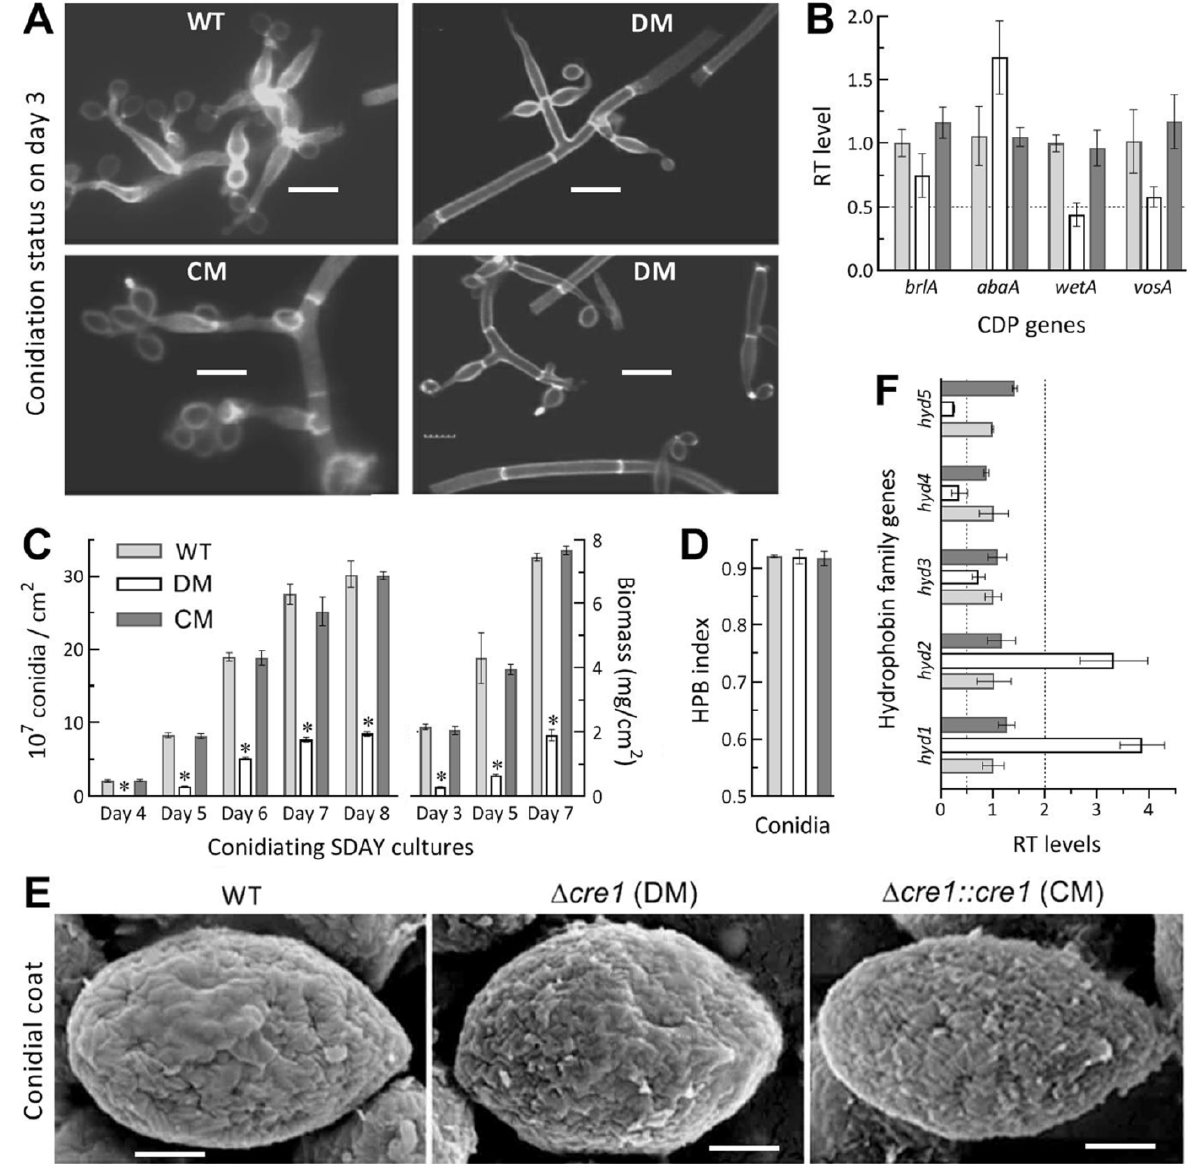
Figure 4. Role of cre1 in sustaining aerial conidiation and conidial hydrophobicity of B. bassiana . ( A ) Microscopic images (scale: 5 μm) for conidiation status of samples taken from 3-day-old SDAY cultures and stained with the cell wall specific dye calcofluor white. ( B ) Relative transcript (RT) levels of three CDP genes and downstream vosA in the 3-day-old SDAY cultures of cre1 mutants with respect to the WT standard. ( C ) Conidial yields and biomass levels quantified from the SDAY cultures during an 8-day incubation at the optimal regime of 25 °C and L:D 12:12. ( D ) Conidial hydrophobicity (HPB) index quantified in an aqueous-organic system. ( E ) SEM images (scale: 0.5 μm) for microstructures of outermost hydrophobin rodlet bundles on conidial surfaces. ( F ) RT levels of hydrophobin family genes in the 3-day-old SDAY cultures of cre1 mutants with respect to the WT standard. All SDAY cultures were initiated by spreading 100 μL of a 10 7 conidia/mL suspension per plate. The dashed line ( B , F ) indicates a significant level of one-fold down- or upregulation. * p < 0.001 in Tukey’s HSD tests. Error bars: SDs of the means from three independent replicates.